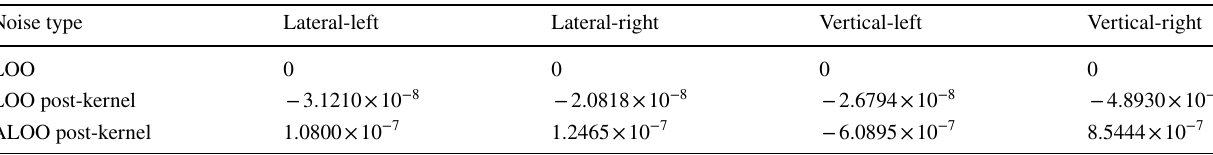
Table 4 Kernel error means of the various noise types and track displacement directions